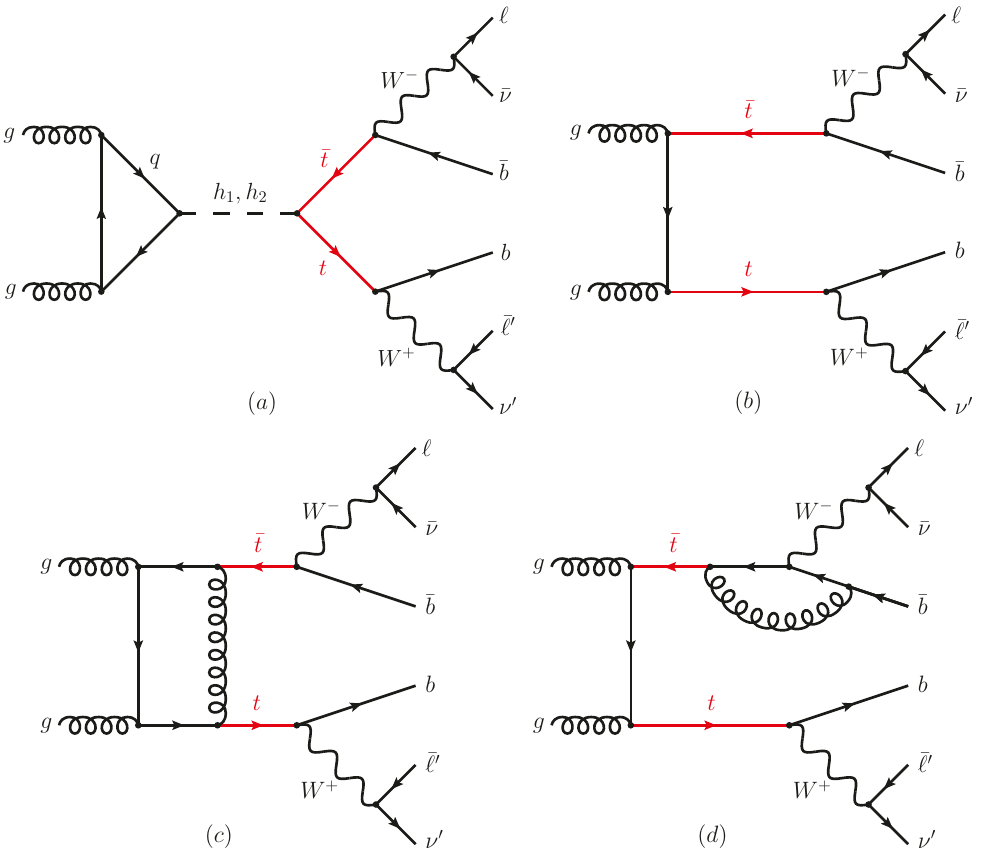
Figure 3 . Representative Feynman graphs for gg ( extended with a real scalar singlet (cid:12)eld. The light ( h 1 ) and heavy Higgs ( h 2 ) production graphs (a) interfere with each other and the gluon-induced LO continuum background graphs (b). Interference with the gluon-induced continuum background at the one-loop level, for which representative graphs are shown in (c) and (d), is also considered. The process is calculated in double pole approximation with a pair of on-shell top quarks